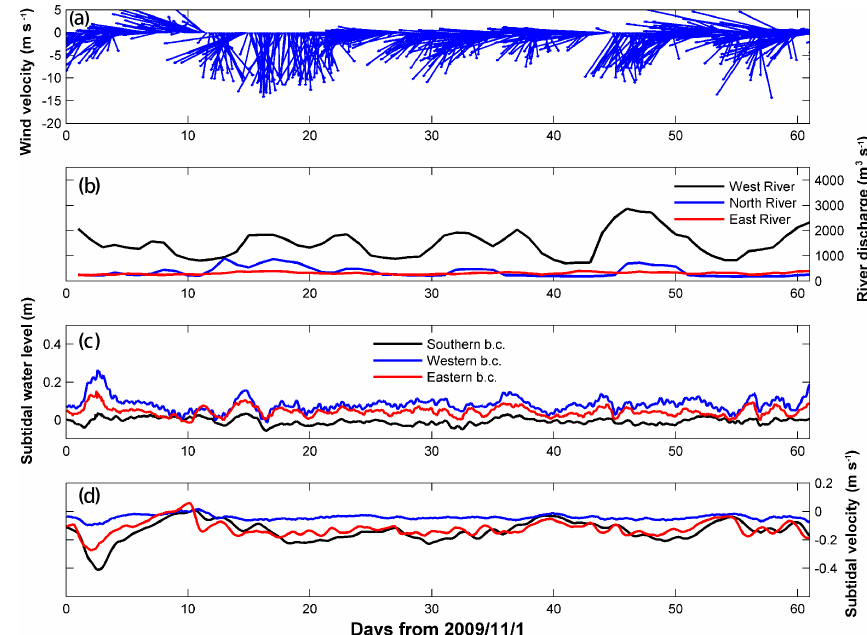
Figure 3. The external forcings for the model verification period from 1 November to 31 December 2009. Panel (a) time series of wind vector at the Hong Kong Meteorological station; panel (b) daily river discharge from the West, North and East Rivers; panel (c) subtidal water levels at the open ocean boundaries; panel (d) subtidal alongshore current at the open ocean boundaries.